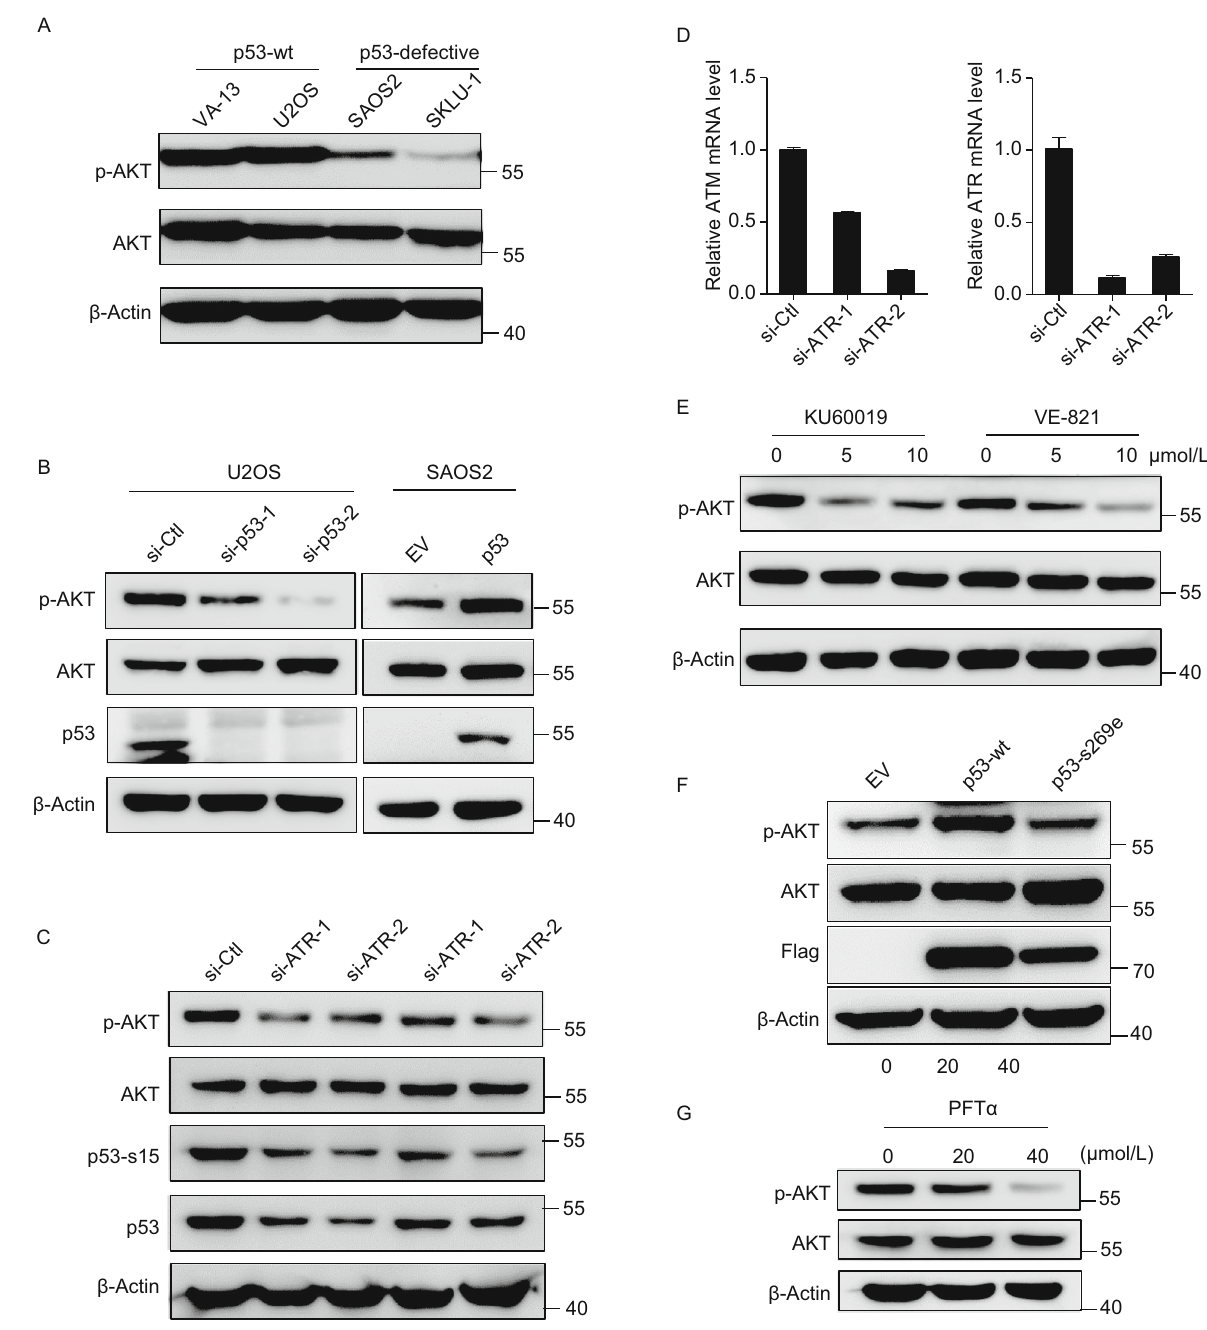
Figure 4. AKT is phosphorylated in p53-dependent manner in ALT cells. (A) Western blot determination of total and phosphorylated AKT (S473) in p53-positive (VA13, U2OS) and p53-defective (SAOS2, SKLU-1) ALT cells. (B) Knockdown of p53